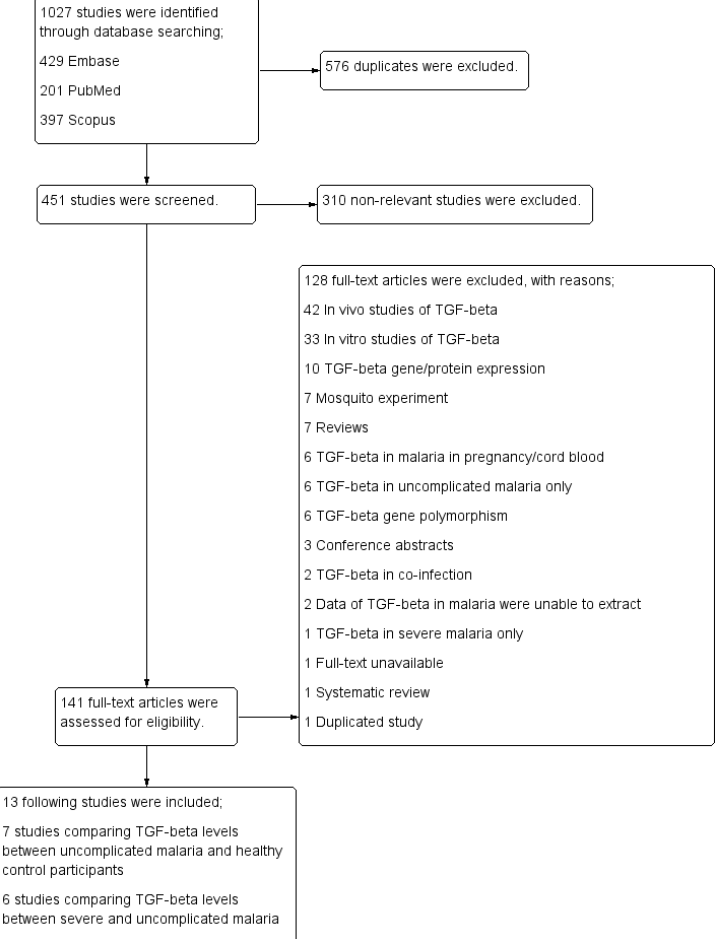
Figure 1. Study flow diagram.